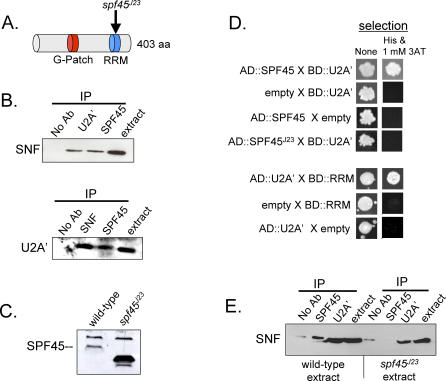
Association between SPF45 and the U2 nsRNP Is Mediated by a Direct Interaction between the C-Terminal End of SPF45 and U2A′(A) Diagram of the 403–amino-acid SPF45 protein. An arrow indicates the position of the P-element insertion in spf45J23.
(B) Western blots of U2A′, SPF45, and SNF immunoprecipitations (IP) from nuclear extracts showing that SPF45 can be co-immunoprecipitated with SNF and U2A′. Previous studies have shown that SNF and U2A′ directly interact [26] and are included here as positive controls.(C) Western blot of extracts made from wild-type and spf45 mutant animals probed with a polyclonal antibody against SPF45 shows that the expected size band is replaced by an ∼37 kD band in spf45J23. In extracts made from adults (but not in nuclear extracts made from embryos), the SPF45 antibody picks up an additional higher molecular weight cross-reacting band of unknown origin, which can serve as a loading control.(D) Yeast two-hybrid interactions showing that SPF45 interacts with U2A′, and that this interaction is mediated by the RRM domain. Positive interactions were tested by assaying the ability of the transformed yeast to grow on selective media after 3 days.(E) Western blots of U2A′ and SPF45 immunoprecipitations (IP) from wild-type and mutant lysates showing that the SPF45J23 does not co-immnoprecipitate with SNF in mutant extracts, whereas the control splicing proteins, SNF and U2A′, are co-precipitated.